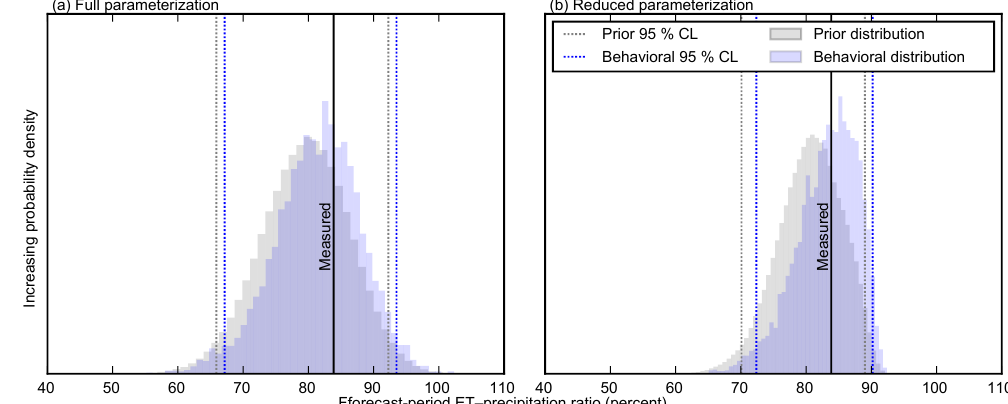
Figure 6. Quantity of interest QOI-3: simulated forecast period (posttreatment) ET as a percentage of precipitation. All 95% confidence intervals bracket the measured value. However, the conditioning process has done little to decrease uncertainty, as the behavioral distributions are similar to the prior distributions for both model parameterizations.